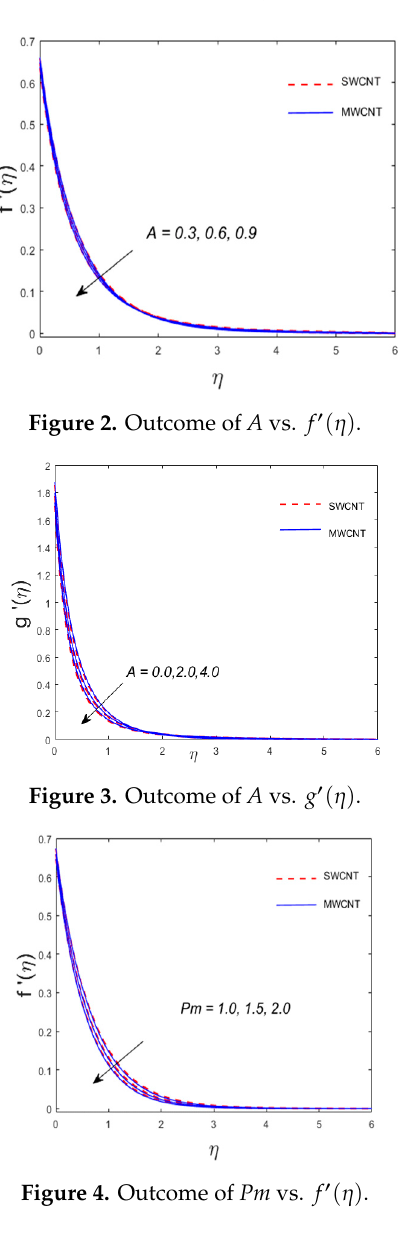
Figure 5. Outcome of Pm vs.